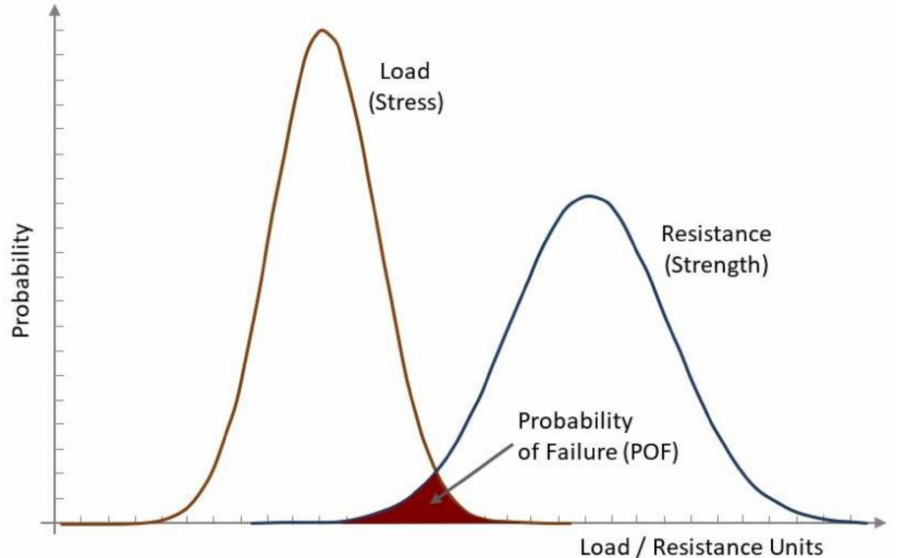
Figure 2. Probability of failure of load-resistance normal